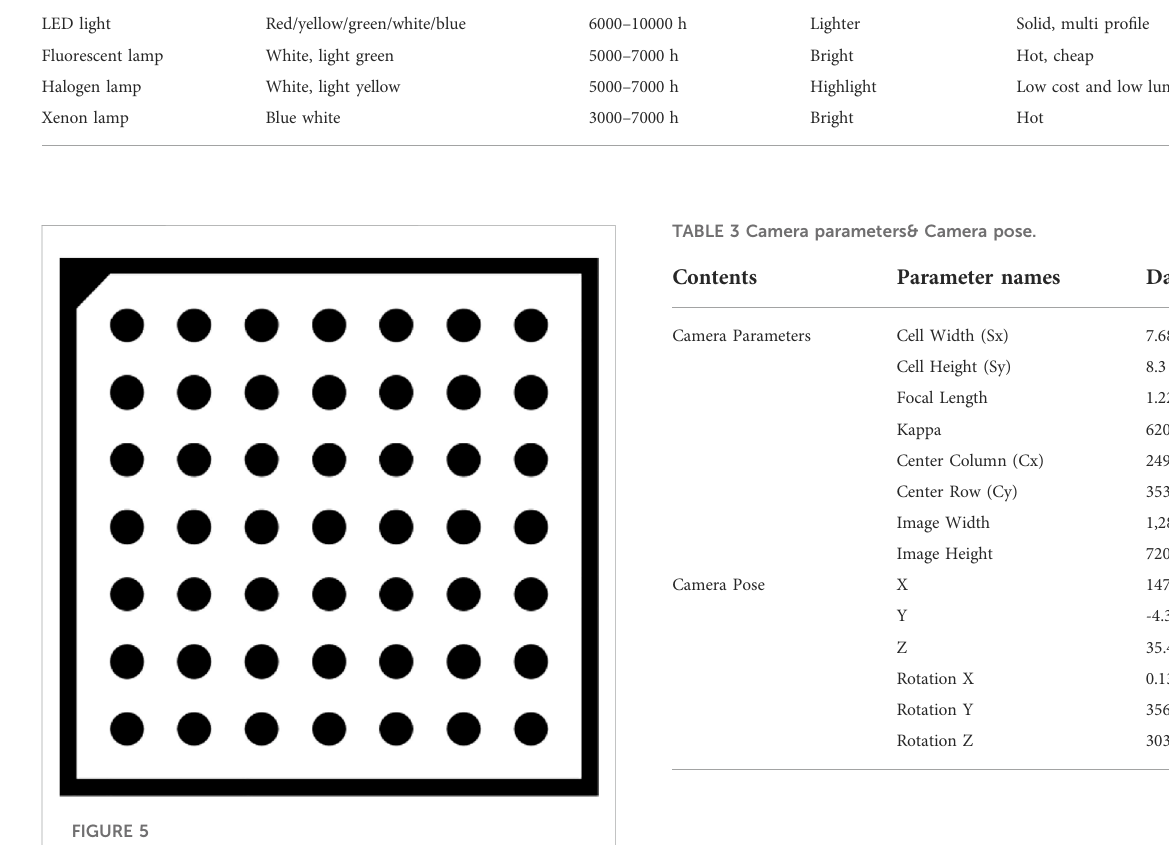
FIGURE 5 7 × 7 dot calibration plate.